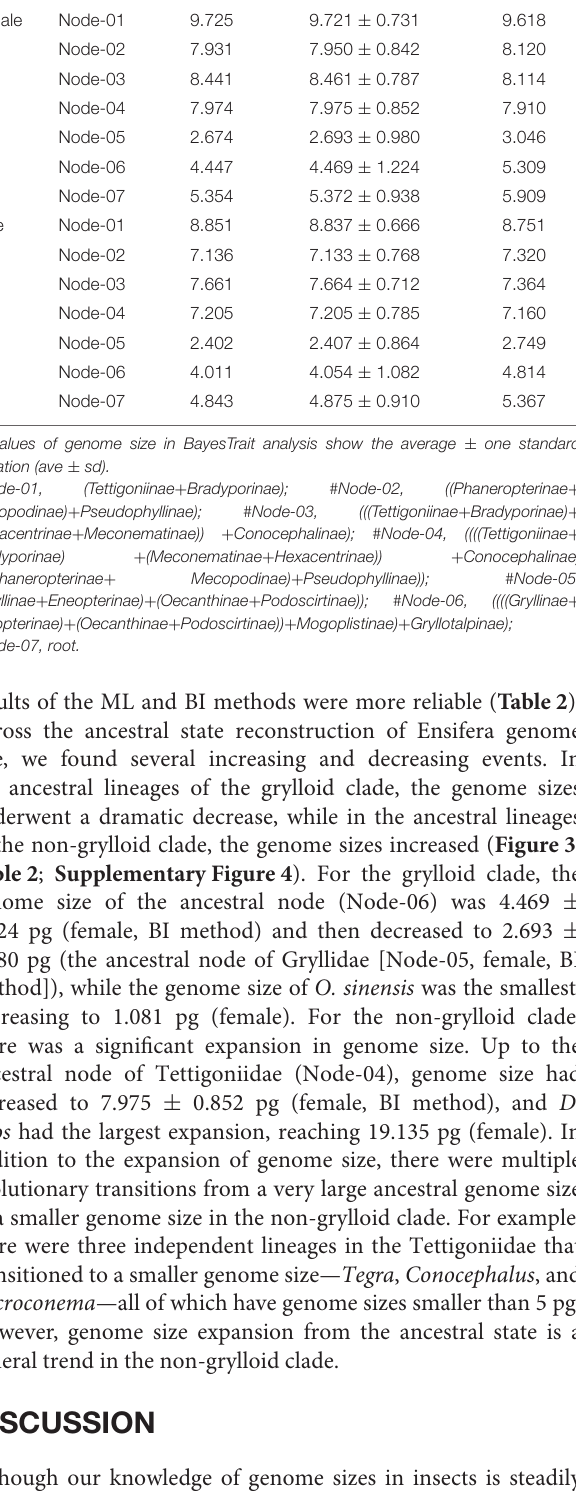
TABLE 2 | The estimated genome size in seven ancestral nodes inferred using fastAnc, BayesTrait, and Mesquite.